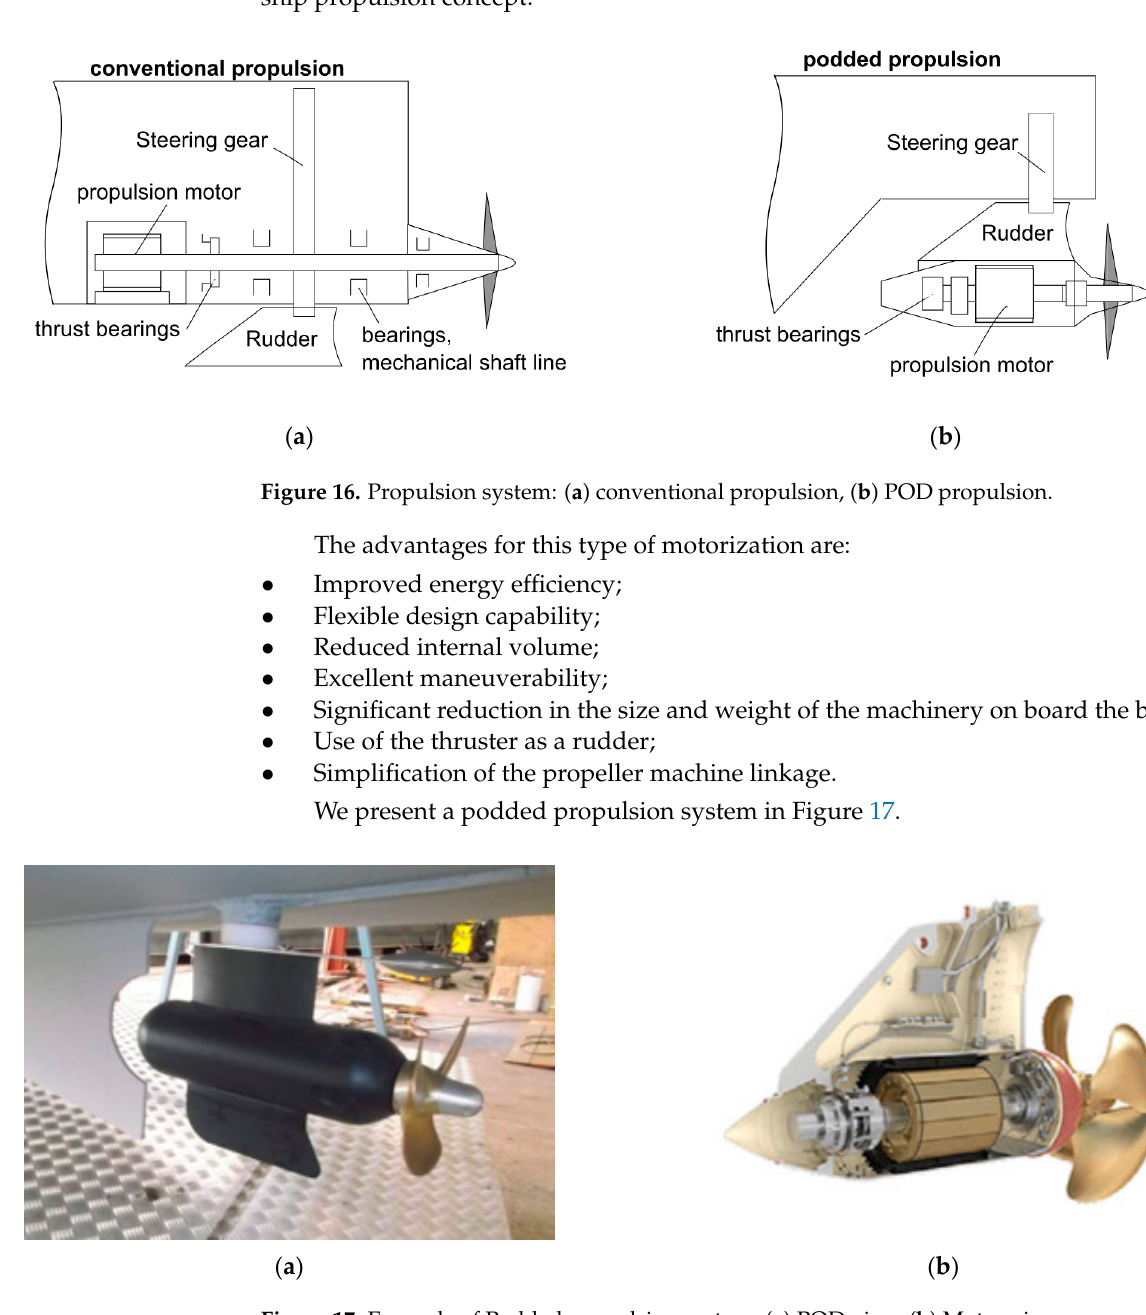
Figure 17. Example of Podded propulsion system: ( a ) POD view, ( b ) Motor view.